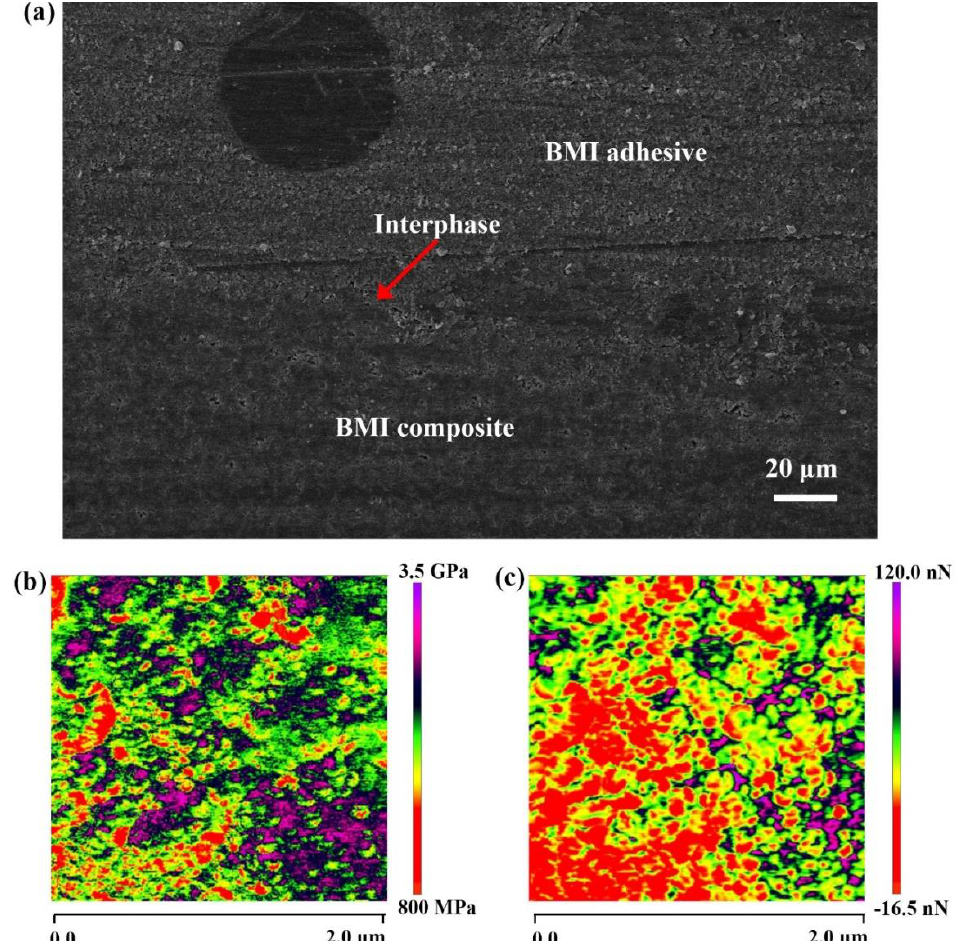
Figure 10. ( a ) SEM image of the bonding interface in the BMI adhesive-bonded composite joint. ( b ) Modulus mapping of the cured BMI adhesive. ( c ) Adhesion to the AFM probe mapping of the cured BMI adhesive.